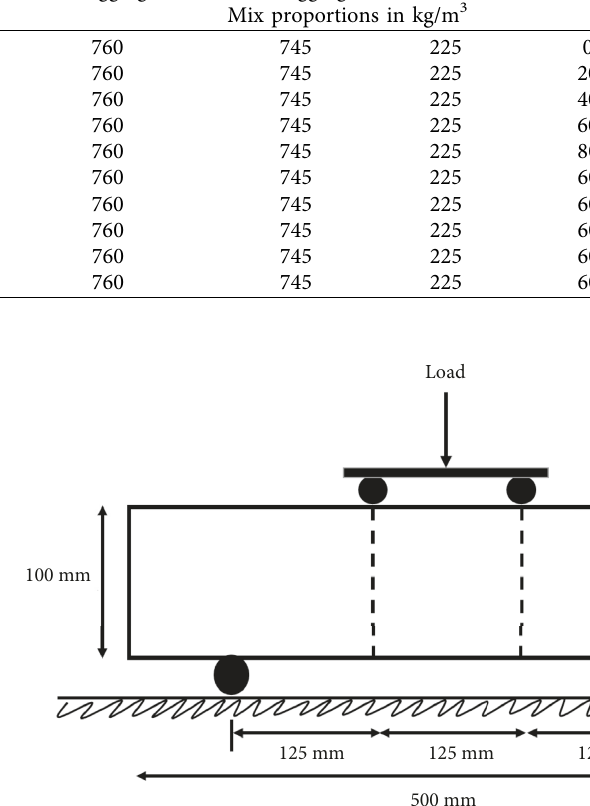
Figure 2: The arrangement for testing flexural